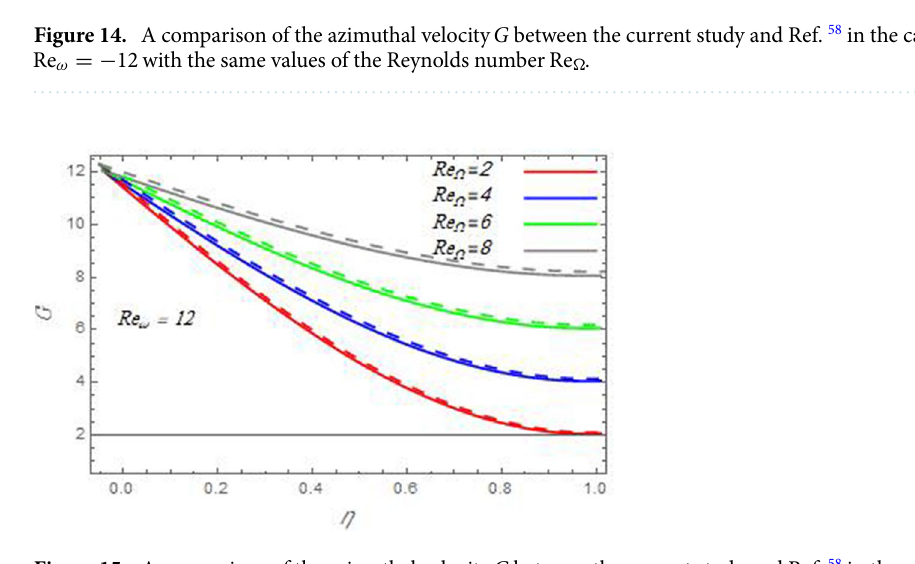
Figure 15. A comparison of the azimuthal velocity G between the current study and Ref. 58 in the case Re ω 12 with the same values of the Reynolds number Re (cid:31) =